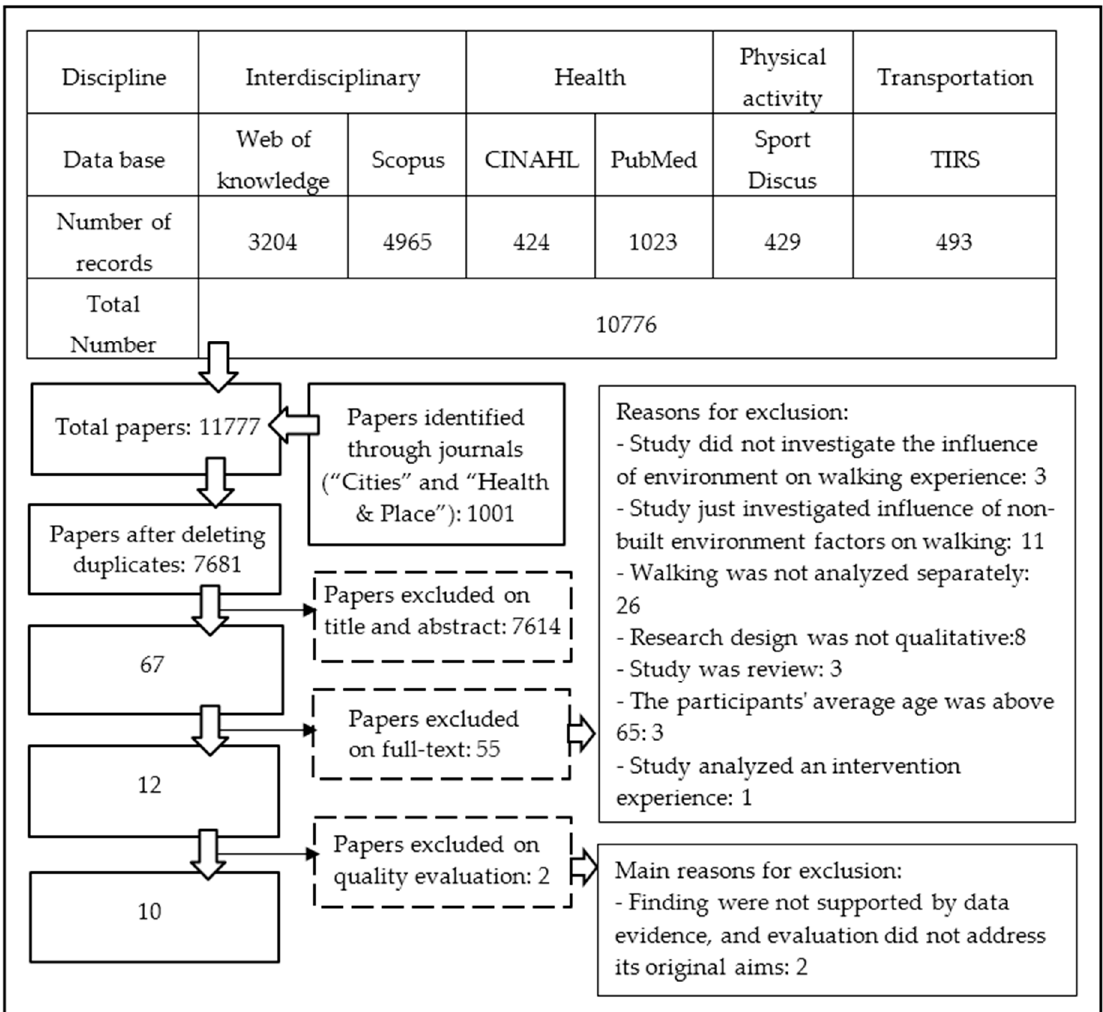
Figure 1. Diagram for access to relevant papers.